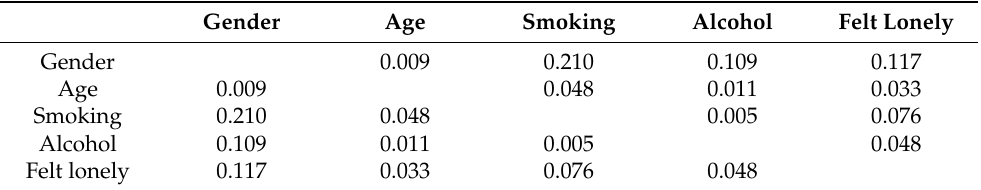
Table A1. Testing for multicollinearity among the independent variables significant at 0.25 in the univariate analysis examining the factors associated with correct recognition of depression/intention to seek help/adequate MHL.